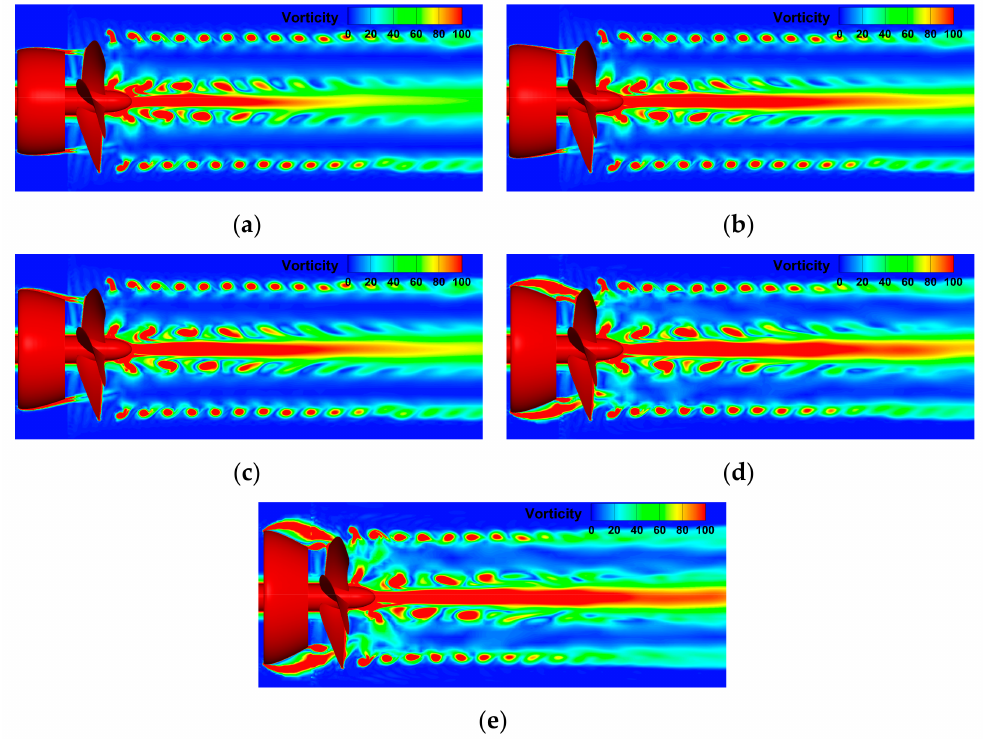
Figure 16. Contours of vorticity computed in the longitudinal plane at D N / D = 0.7 : ( a ) θ = 0 ◦ , ( b ) θ = 5 ◦ , ( c ) θ = 10 ◦ , ( d ) θ = 15 ◦ , ( e ) θ = 20 ◦